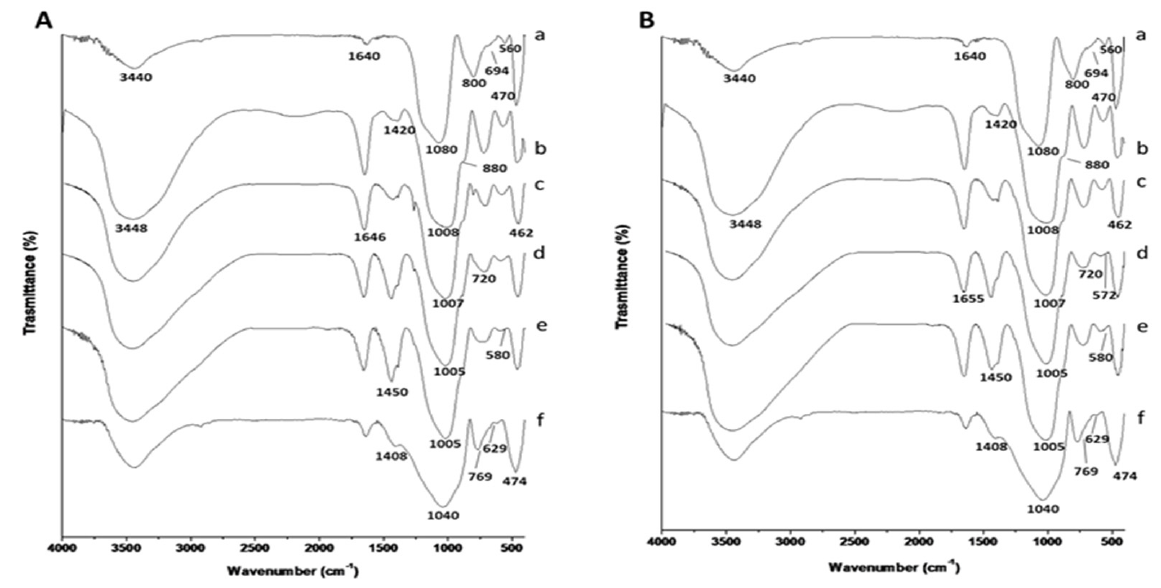
Figure 4. FT-IR spectra of (a) MK, (b) GP, (c) GP/WG 20%, (d) GP/WG 50%, (e) GP/WG 60%, and (f) WG at 28 days of curing time for ( A ) 37–53 μ m and ( B ) 75–105 μ m grain size.